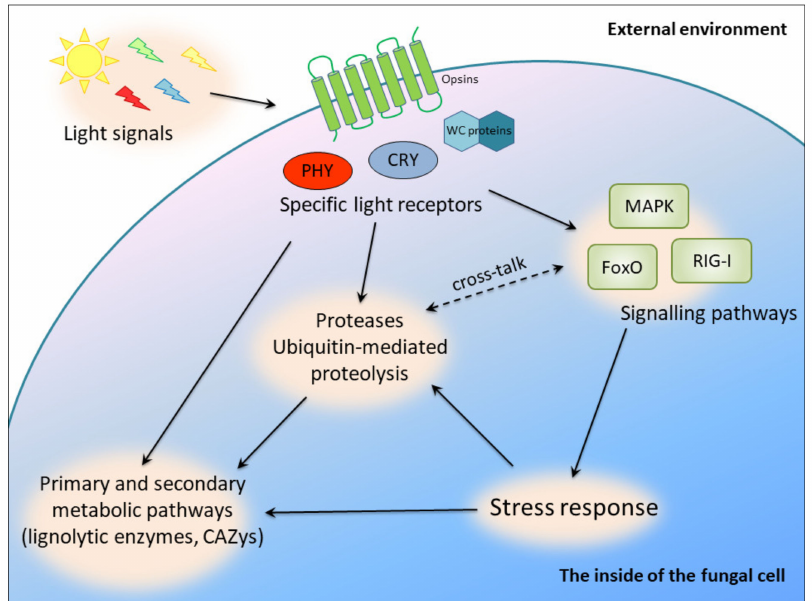
Figure 5. Putative light-dependent cross-regulatory pathways in C. unicolor involving proteases; PHY, phytochromes; CRY, cryptochromes; WC proteins, white collar